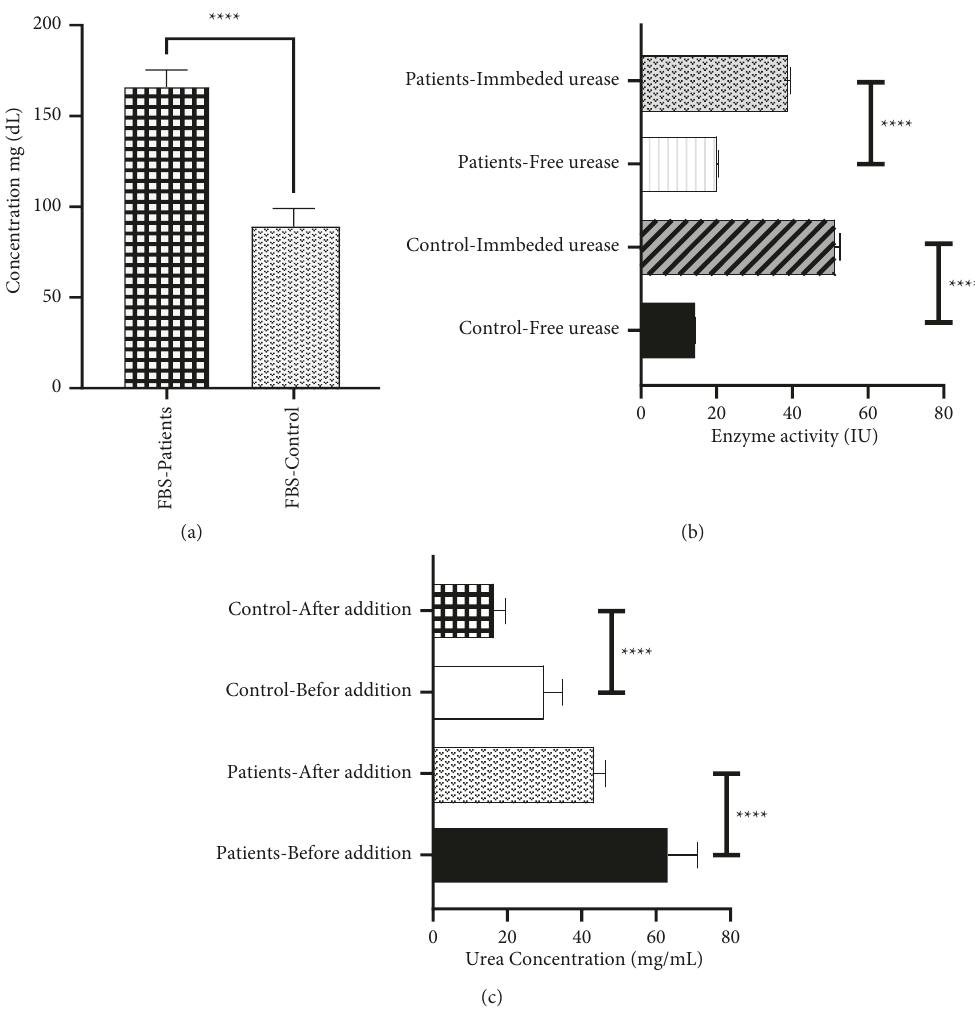
Figure 5: Effect of the immobilized urease enzyme on the activity of serum urease enzyme and urea concentration of nephropathy diabetic patients and control volunteers: (a) levels of FBS in patients compared to that in control, (b) effect of the immobilized urease enzyme on the enzyme activity, and (c) effect of the immobilized urease enzyme on the urea level. All data were collected in triplicates. The black bars refer to the standard error of means SEM. The significance level of differences p was < 0.0001. Table 2: Levels of free and embedded urease in patients compared with controls. Values were expressed by mean ±